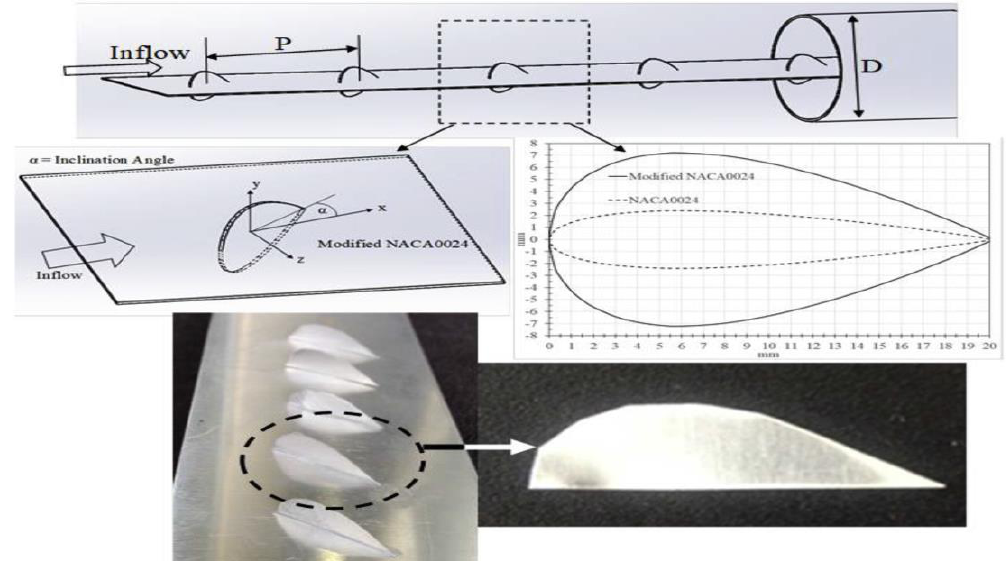
Figure 15: Photograph and geometry of modified-NACA0024 airfoil-shaped insert